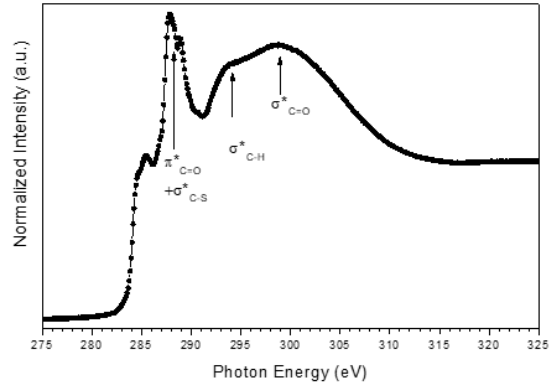
Figure 2. C k-edge NEXAFS spectrum of AgNPS recorded at 20 ◦ incidence angle.